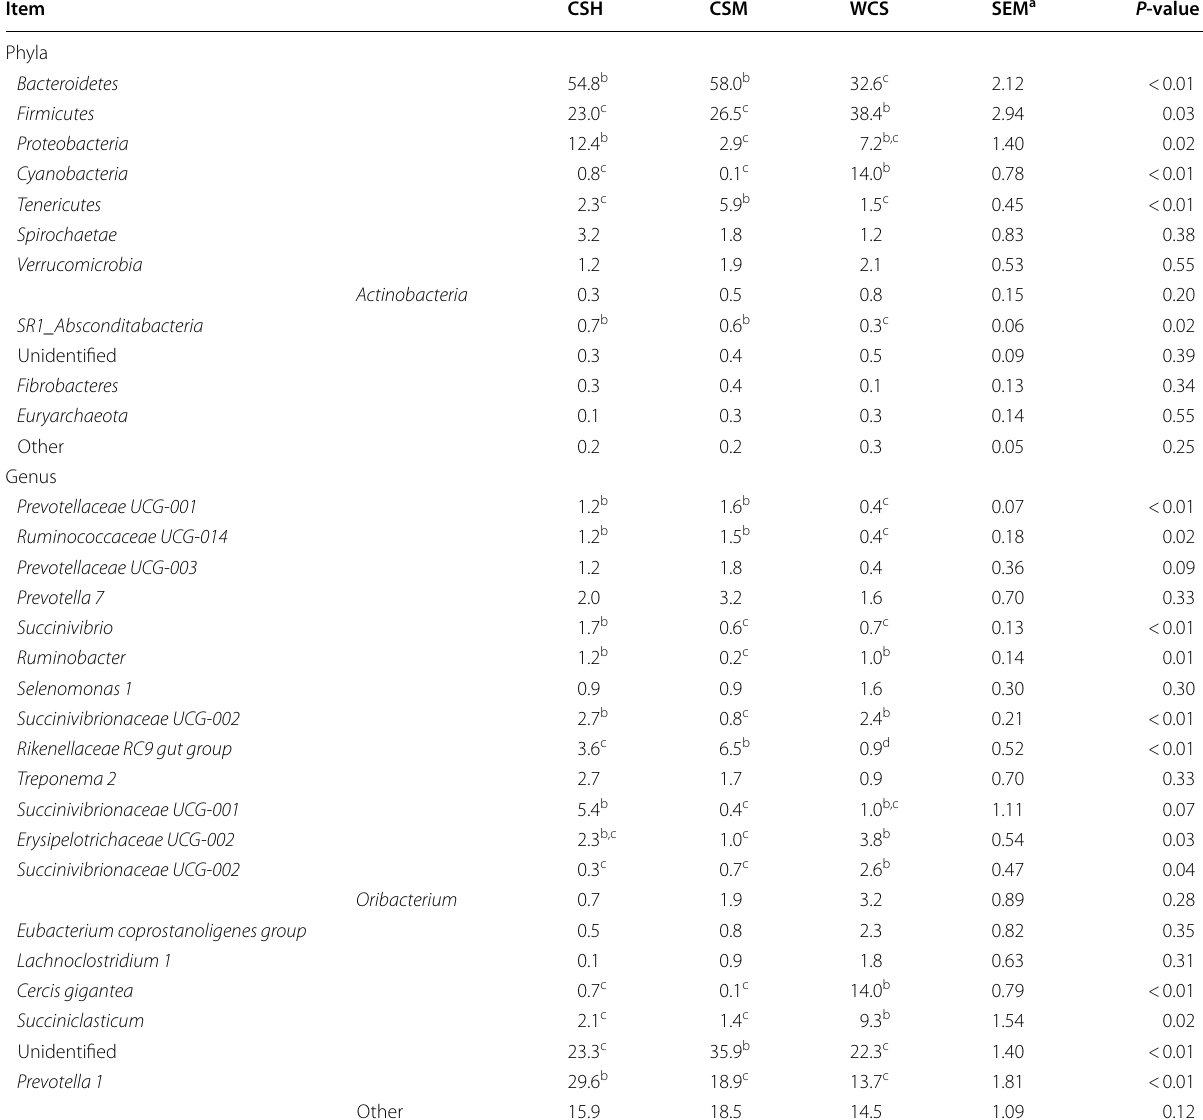
Table 3 Percentage contribution of sequences (%) evaluated at the phyla and genus level across three‑kinds of incubated cotton by‑products samples of 24